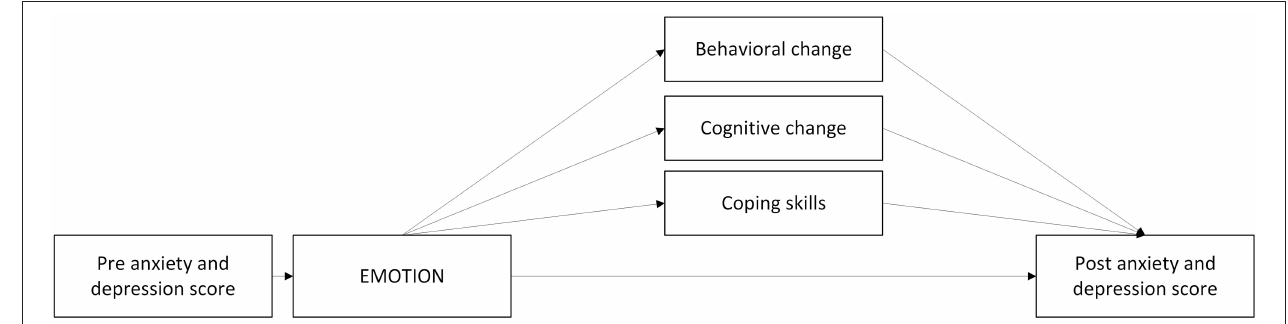
FIGURE 2 | Proposed mediators of change with the EMOTION